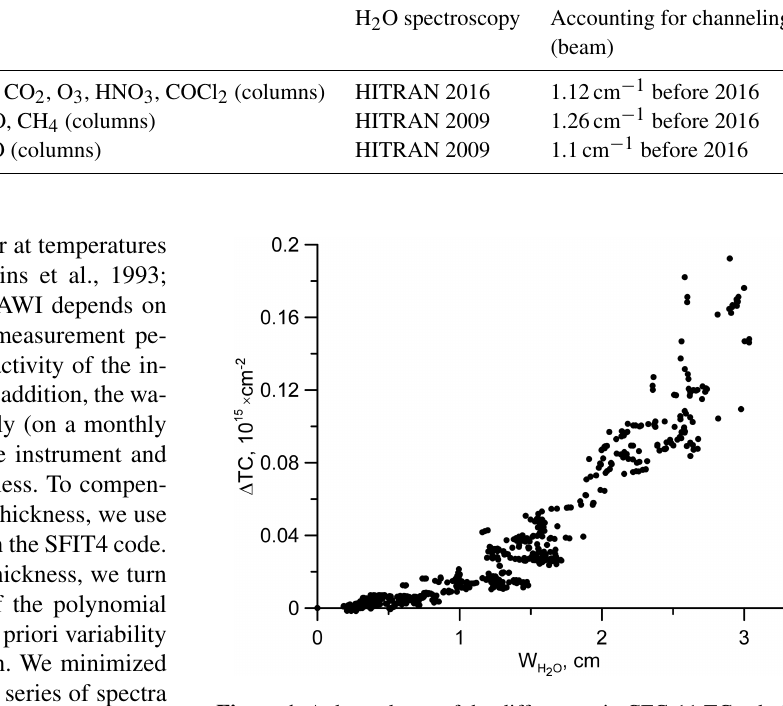
Figure 1. A dependence of the differences in CFC-11 TCs, derived without and with taking the continuum on precipitable water during 2018 into